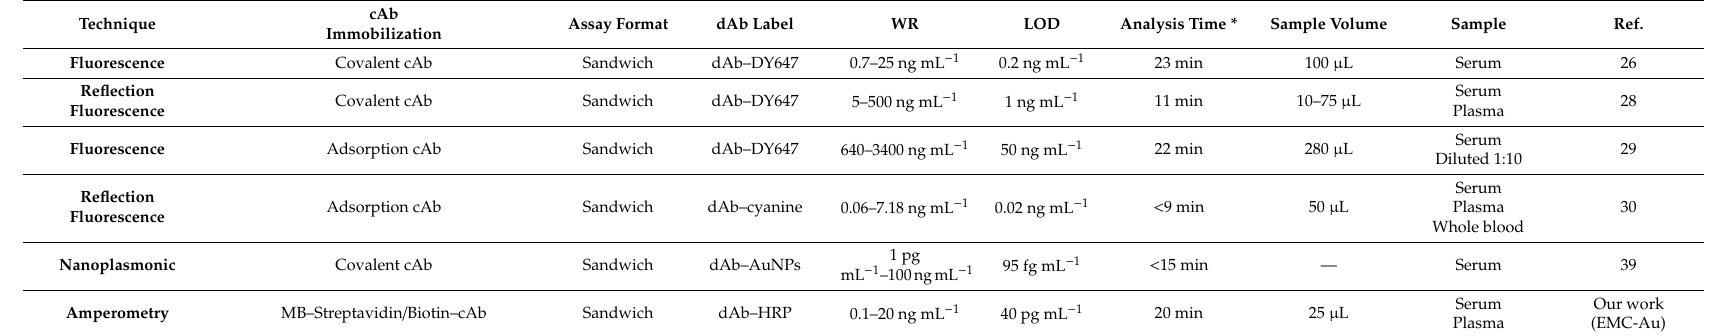
Table 5. Overview of microfluidics immunoassays for PCT